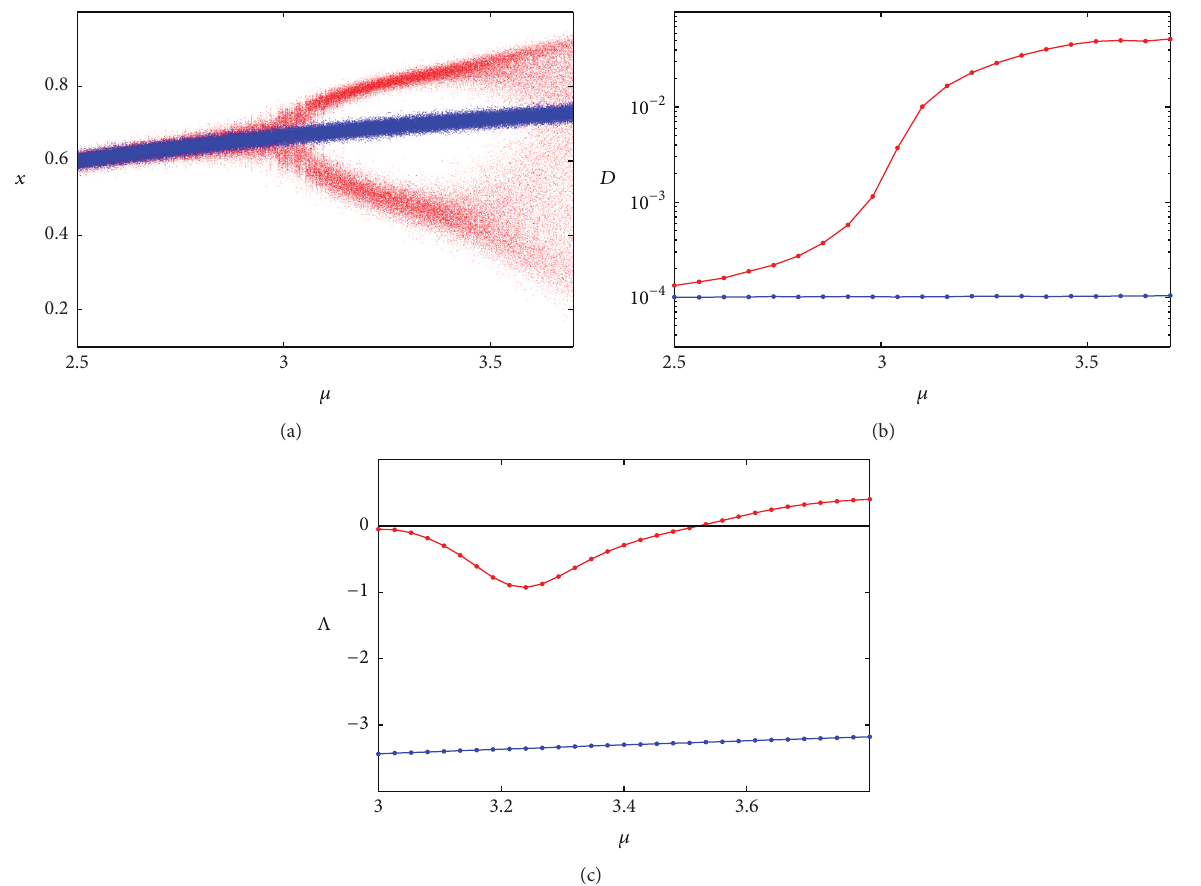
Figure 1: Stochastic Verhulst model for 𝜀 = 0.01 , 𝜎 = 1 , and 𝜑 = 0.1 without control (red) and with optimal control (blue): (a) random states; (b) dispersion; (c) largest Lyapunov